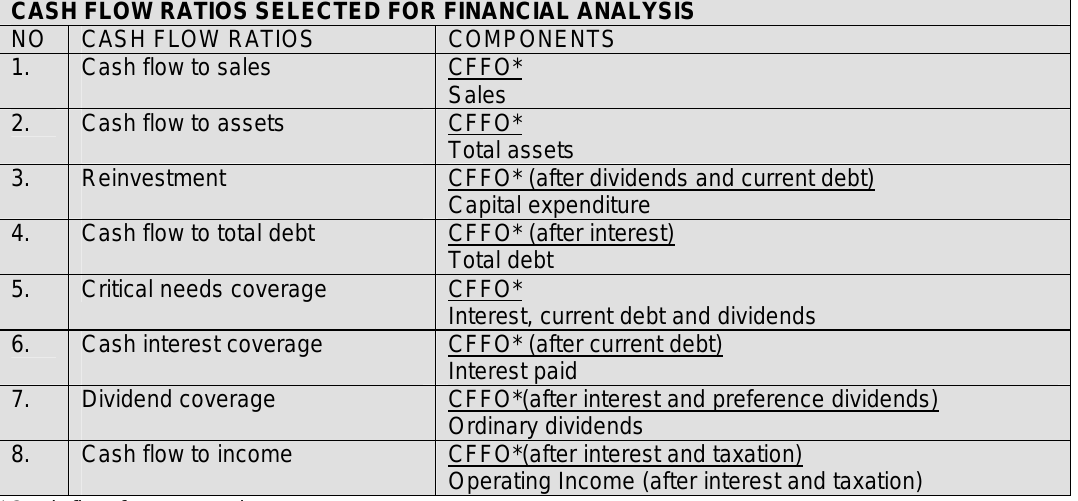
Table 1 lists eight selected cash flow ratios to evaluate failed and non-failed entities. Table 1: Cash flow ratios selected for financial analysis CASH FLOW RATIOS SELECTED FOR FINANCIAL